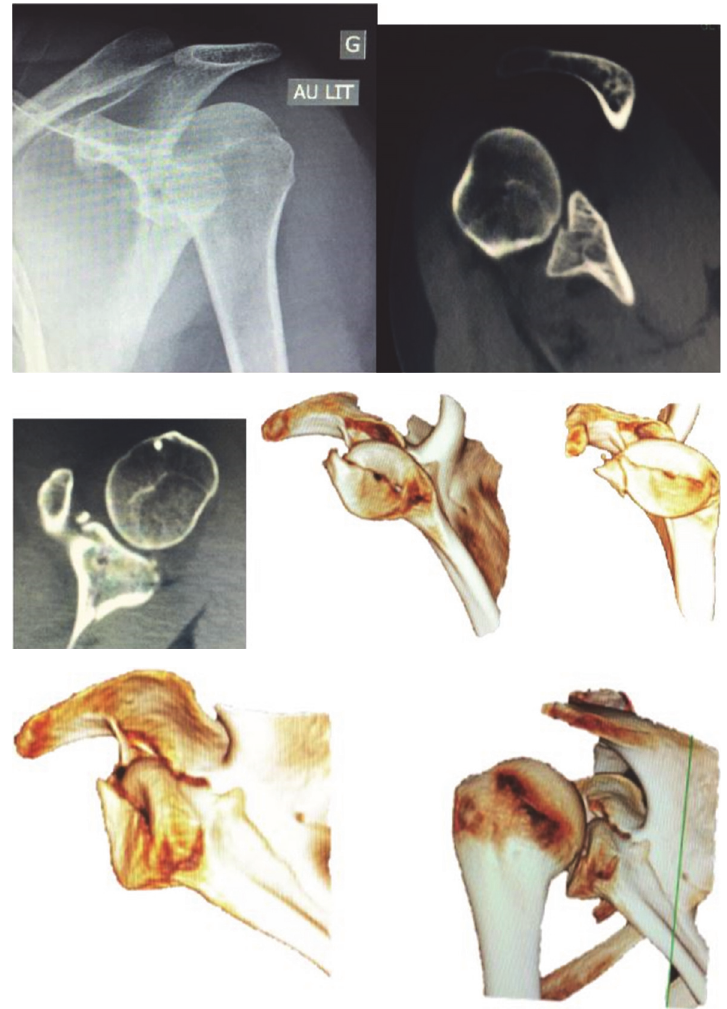
Figure 2: X-ray and CT with 3D images of an articular glenoid fracture.